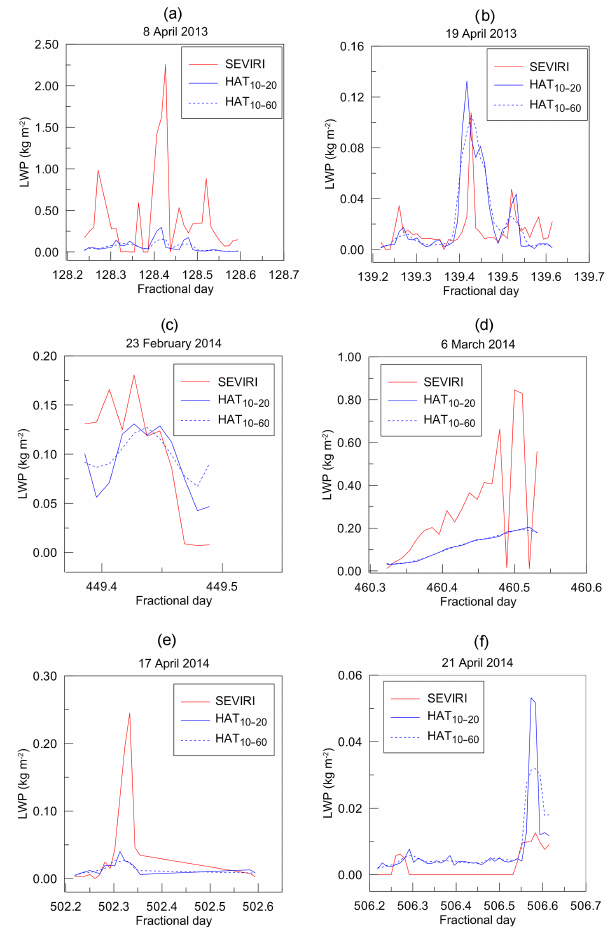
Figure 7. The examples of instantaneous measurements of LWP by SEVIRI and by HATPRO (two HATPRO data sets used were HAT 10 − 20 and HAT 10 − 60 ). Several days of the CD season are shown (1 day is one panel).